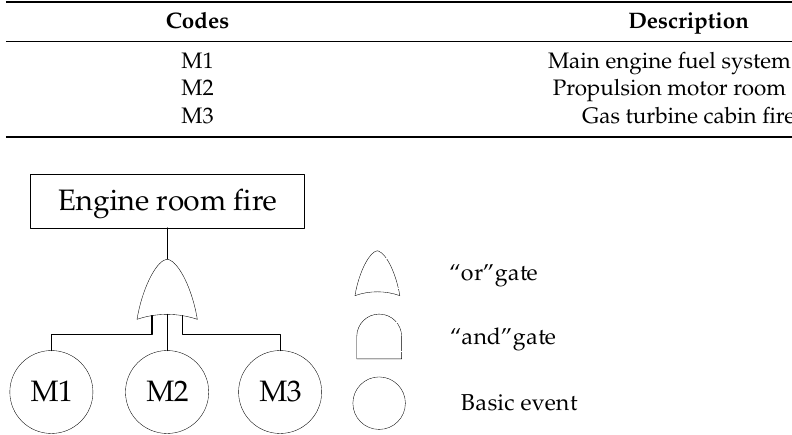
Table 6. Failure information of an engine room fire.